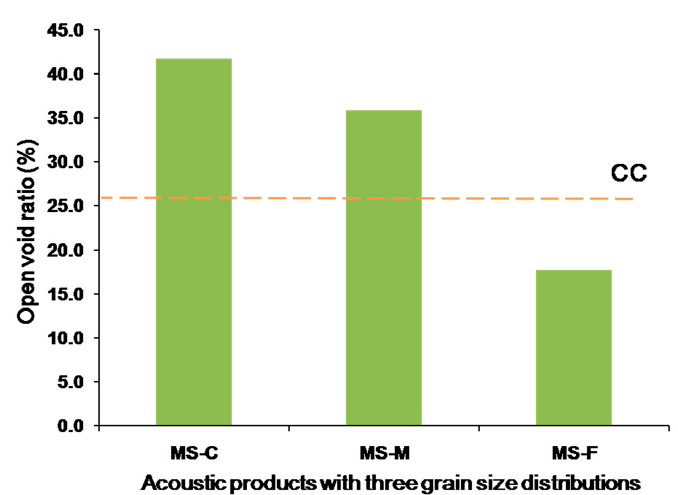
Figure 5. Open void ratio of the three acoustic products compared with coarse porous cement (CC).